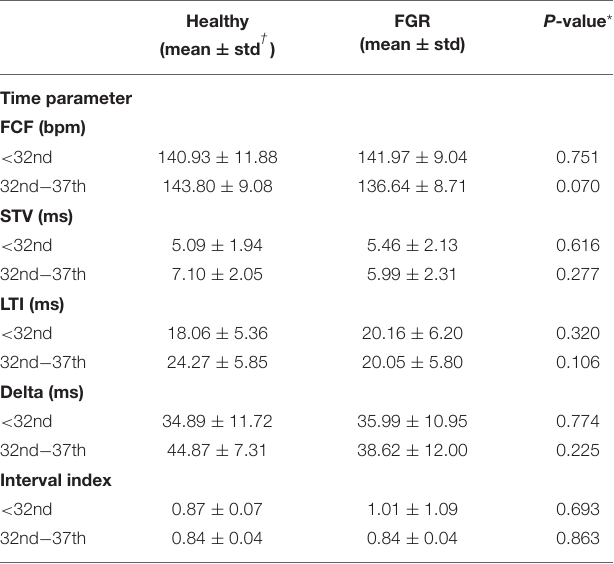
TABLE 2 | Results of computerized FHR monitoring comparison between Healthy and FGR fetuses.